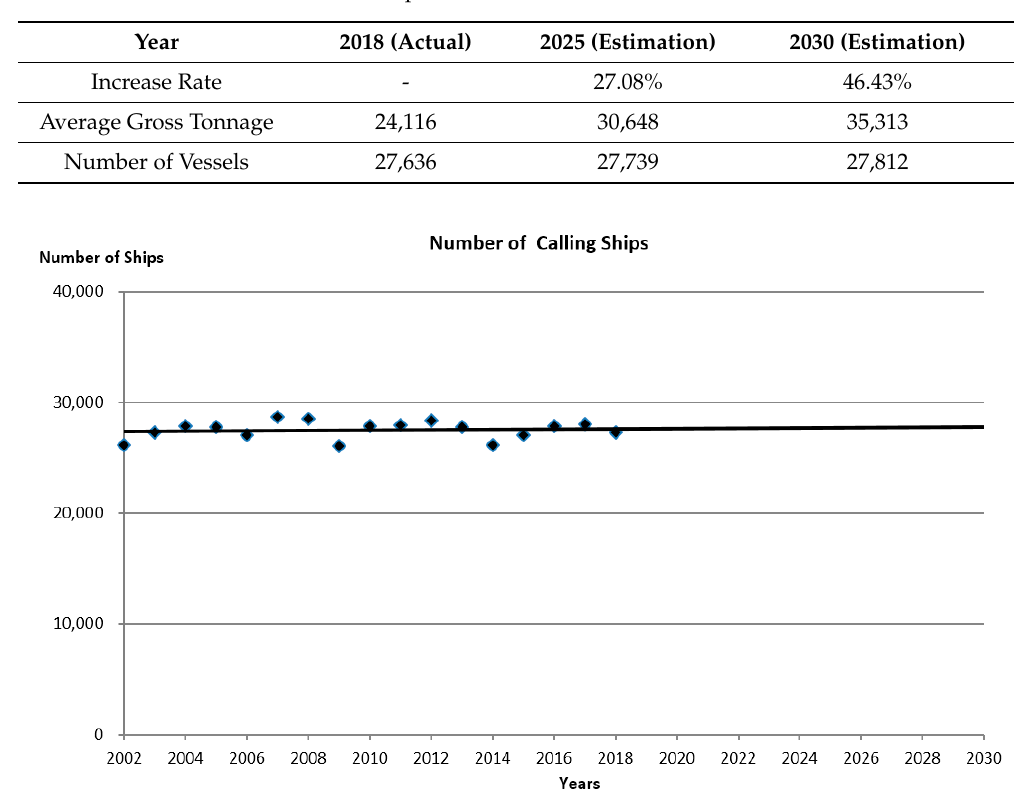
Figure 7. Changes in the Number of Vessels (17 Years in Busan Port).